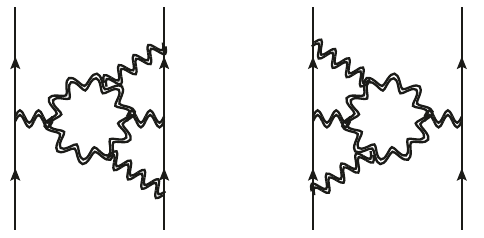
3 and 3 1 transitions. Notice ! ! 3 ! 2 (cid:15) dimensions, in (cid:0)